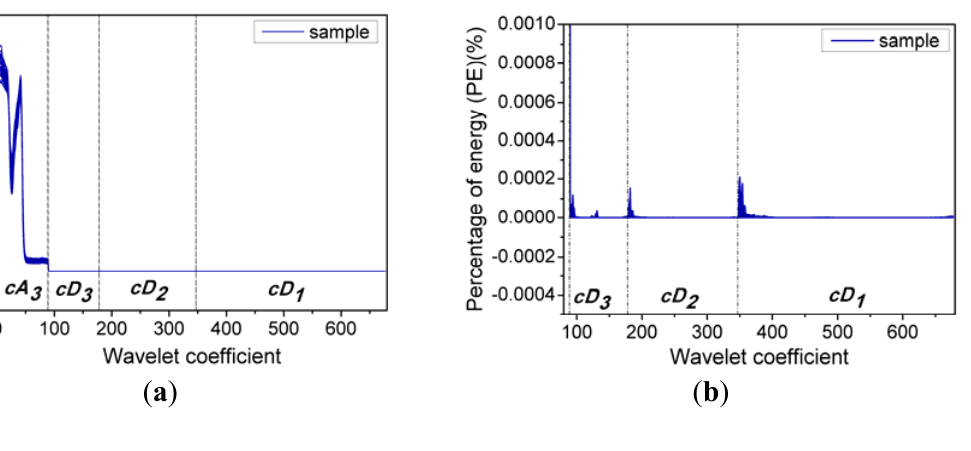
Figure 4. Energy distribution of wavelet